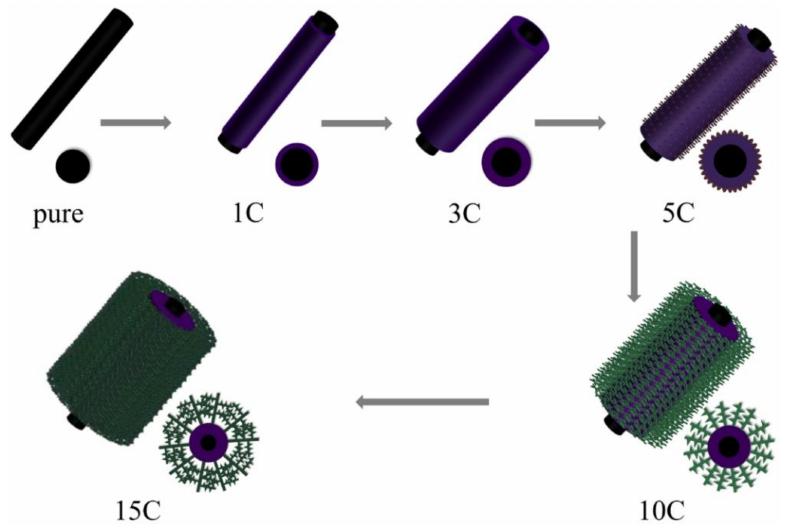
Figure 3. Schematic illustration of the formation processes of PANI on the surface of the CNTF (“C” denotes cycles).